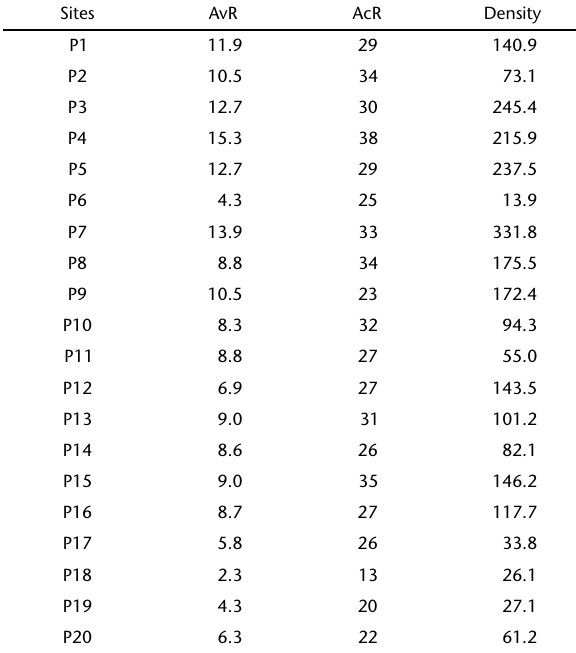
Table IV. Average family richness (AvR), accumulated family richness (AcR), and density (ind/m 2 ) of macroinvertebrates in 20 sites along the Pandeiros River